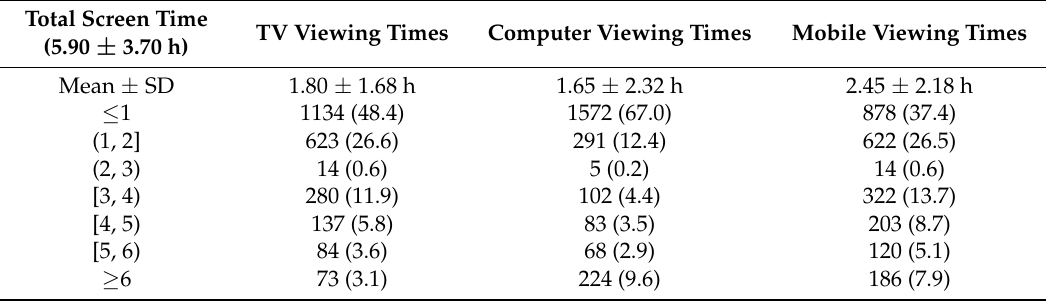
Table 2. Screen times of pregnant women in Chongqing, China ( n , %).